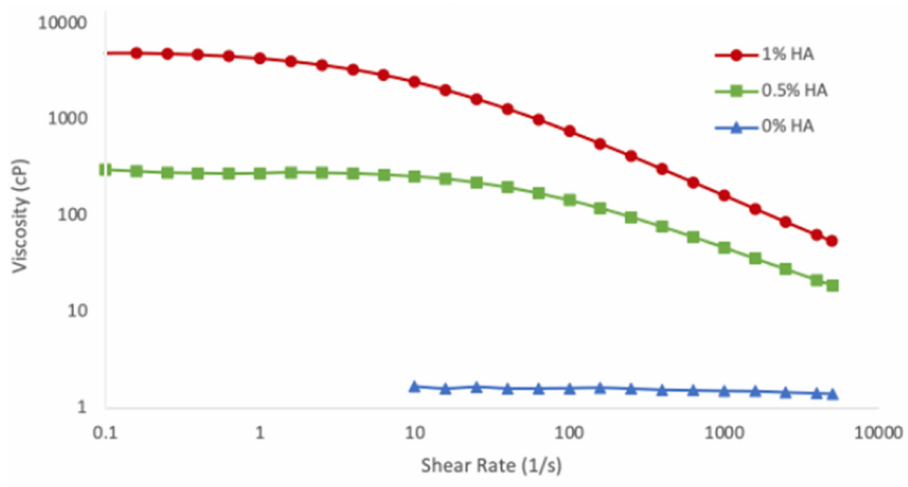
Figure 4. Effect of HA concentration with APG on viscosity vs. shear rate.